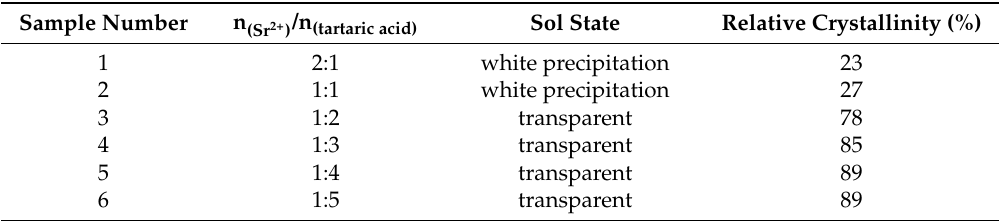
Table 1. Experimental phenomena and relative crystallinity of SrTiO 3 in the system with different molar ratios of Sr 2+ and tartaric